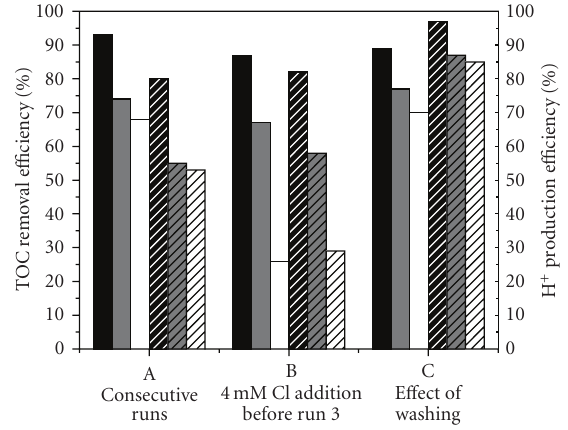
Figure 7: Removal DCA (TOC removal) after 4 hours of illumina- tion using the colloidal-TiO 2 photocatalyst at pH 3 in 3 consecutive runs (1st run (cid:2) , 2nd run , and 3rd run (cid:3) ) the H + production e ffi ciency after 4 hours of illumination is also shown (1st run , 2nd run , and 3rd run ) in set A and with chloride ion addition before the third run (set B). The photocatalyst loading was 0.5 g/L and the light intensity I ≈ 3 . 39 × 10 − 2 Einstein L − 1 h − 1